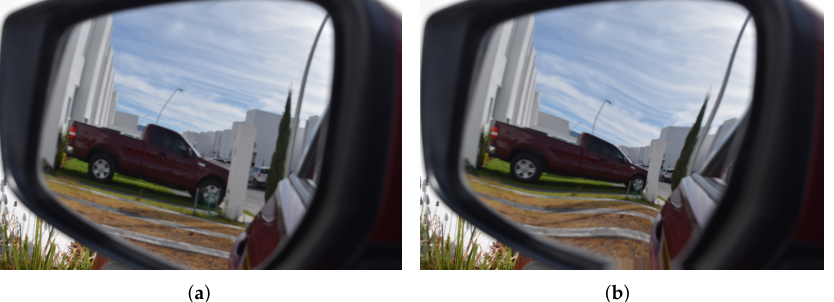
Figure 1. Example of an image of a lateral-view mirror. ( a ) Normal mirror image. ( b ) Mirror image with